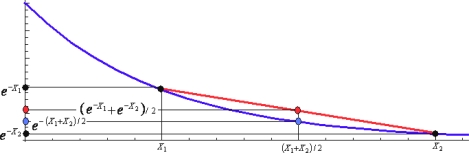
Graphical illustration of the Jensen-Peierls averages’ inequality of Equation (324).